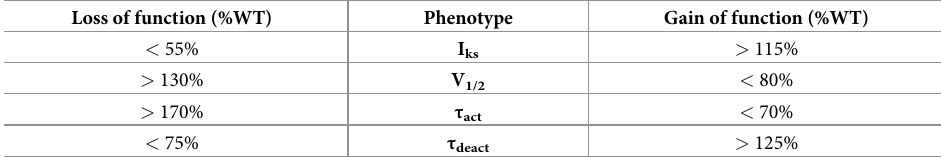
Table 1. Criteria for classifying variants as dysfunctional used in this